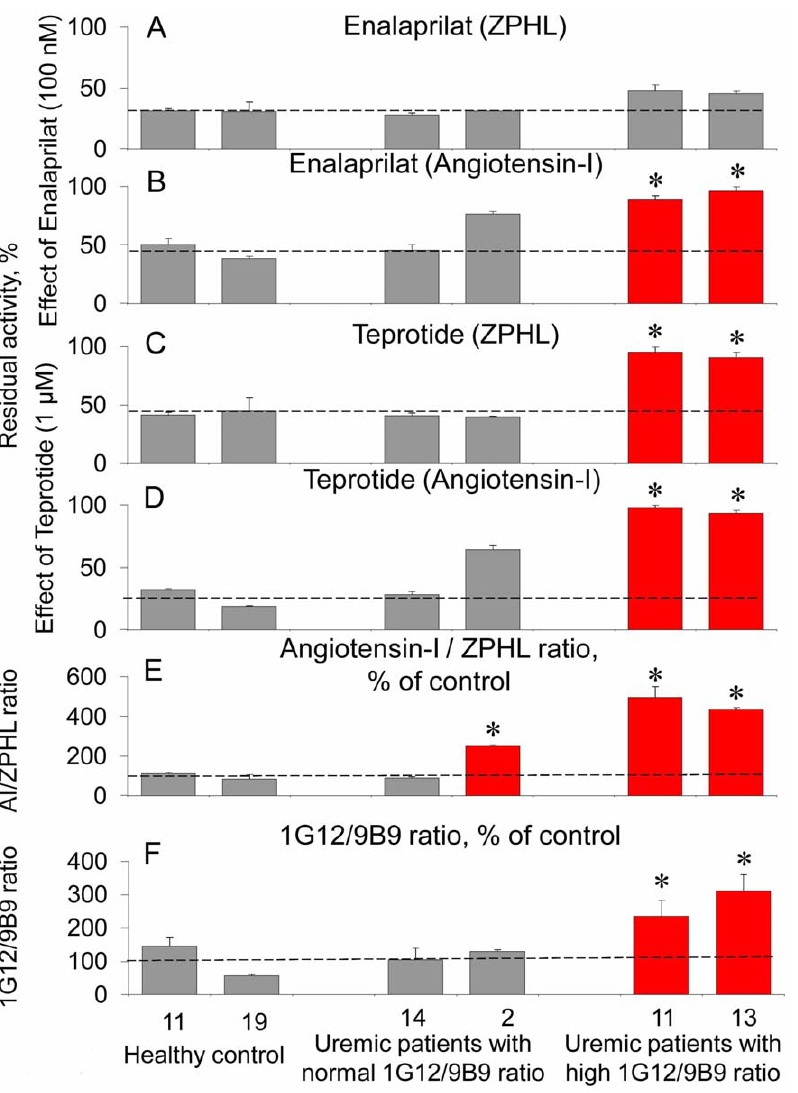
Figure 7. Effect of ACE inhibitors on the activity of plasma ACE in uremia. A – D Citrated plasma samples of uremic patients with normal (patients # 14 and # 2) and high (patients # 11 and # 13) 1G12/9B9 ratio (versus healthy controls, # 11 and # 19) were incubated with ‘‘short’’ ACE inhibitor enalaprilat (100 nM, A and B ) and ‘‘long’’ ACE inhibitor teprotide (1 m M, C and D ) for 1 hour. Data are presented as a residual ACE activity determined with ‘‘short’’ substrate ZPHL (0.5 mM, A and C ) and ‘‘long’’ substrate angiotensin I (0.3 mM, B and D ). Data are presented as a residual ACE activity. E . The ratio of the rates of the hydrolysis of angiotensin I and ZPHL (angiotensin I/ZPHL ratio) for corresponding samples. F . mAb1G12/ 9B9 binding ratio for corresponding samples expressed as % from the mean value for healthy persons. Grey bars – inhibition of ACE activity (A–D) or parameters measured in E–F in uremic samples was not differed from that for healthy patients with low 1G12/9B9 ratio. Red bars –measured parameters were statistically higher than that in healthy patients with low (normal) 1G12/9B9 ratio *, p , 0.05 in comparison with mean value for healthy patients. Data are mean 6 SD from 3 independent experiments (each in duplicates).